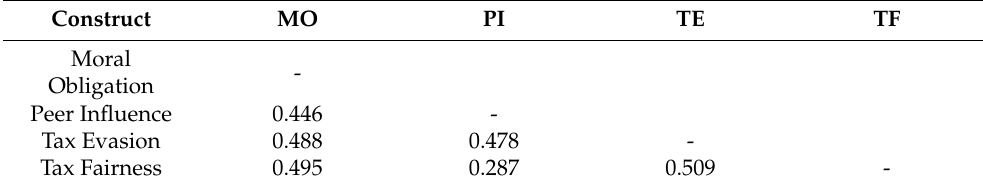
Table 3. HTMT ratio of the constructs (N =